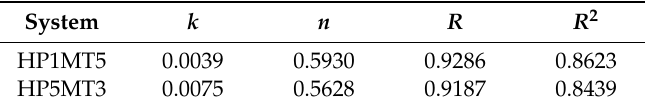
Table 7. Constants of Korsmeyer–Peppas adjusted